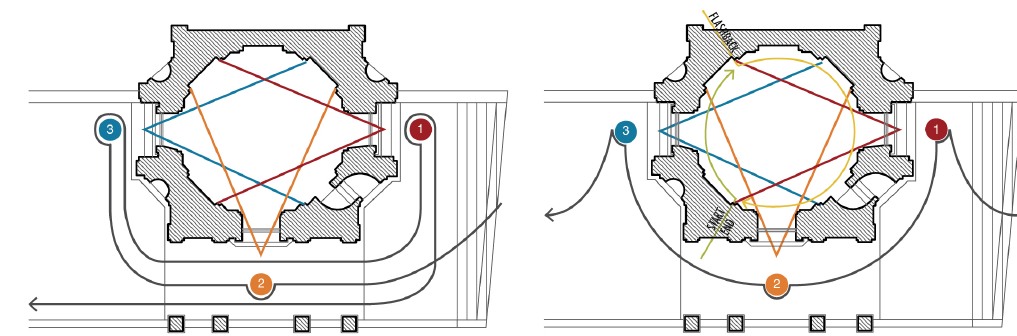
Fig. 10 Comparison between Corsini’s hypothesis and the one referred to the architecture of the